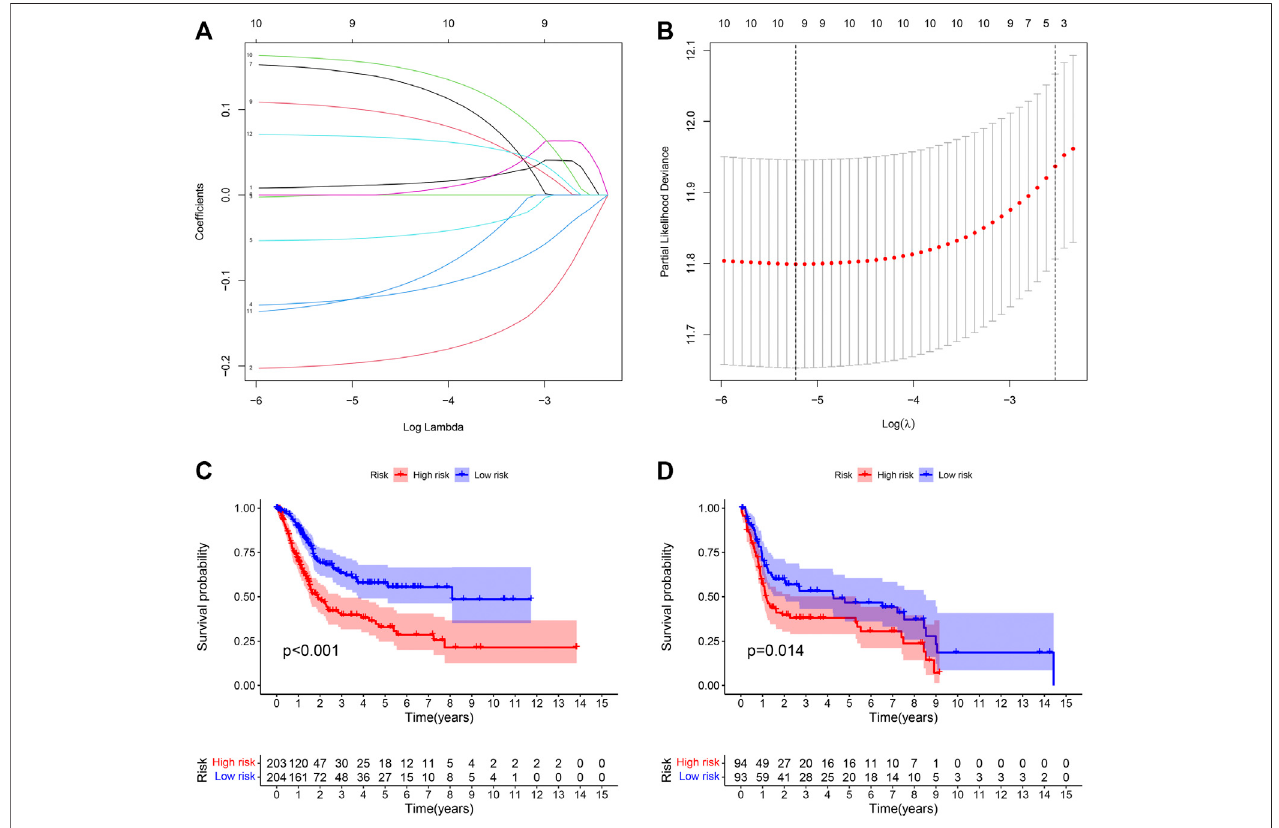
FIGURE 3 | (A) LASSO coef fi cient curves were selected with simulation parameters set to 1000. (B) 10-fold cross-validation of selecting tuning parameter in the LASSO model. (C) Kaplan-Meier survival analysis of the PMB-based risk signature in the TCGA-BLCA cohort. (D) Kaplan-Meier survival analysis of the PMB-based risk signature in the GSECD